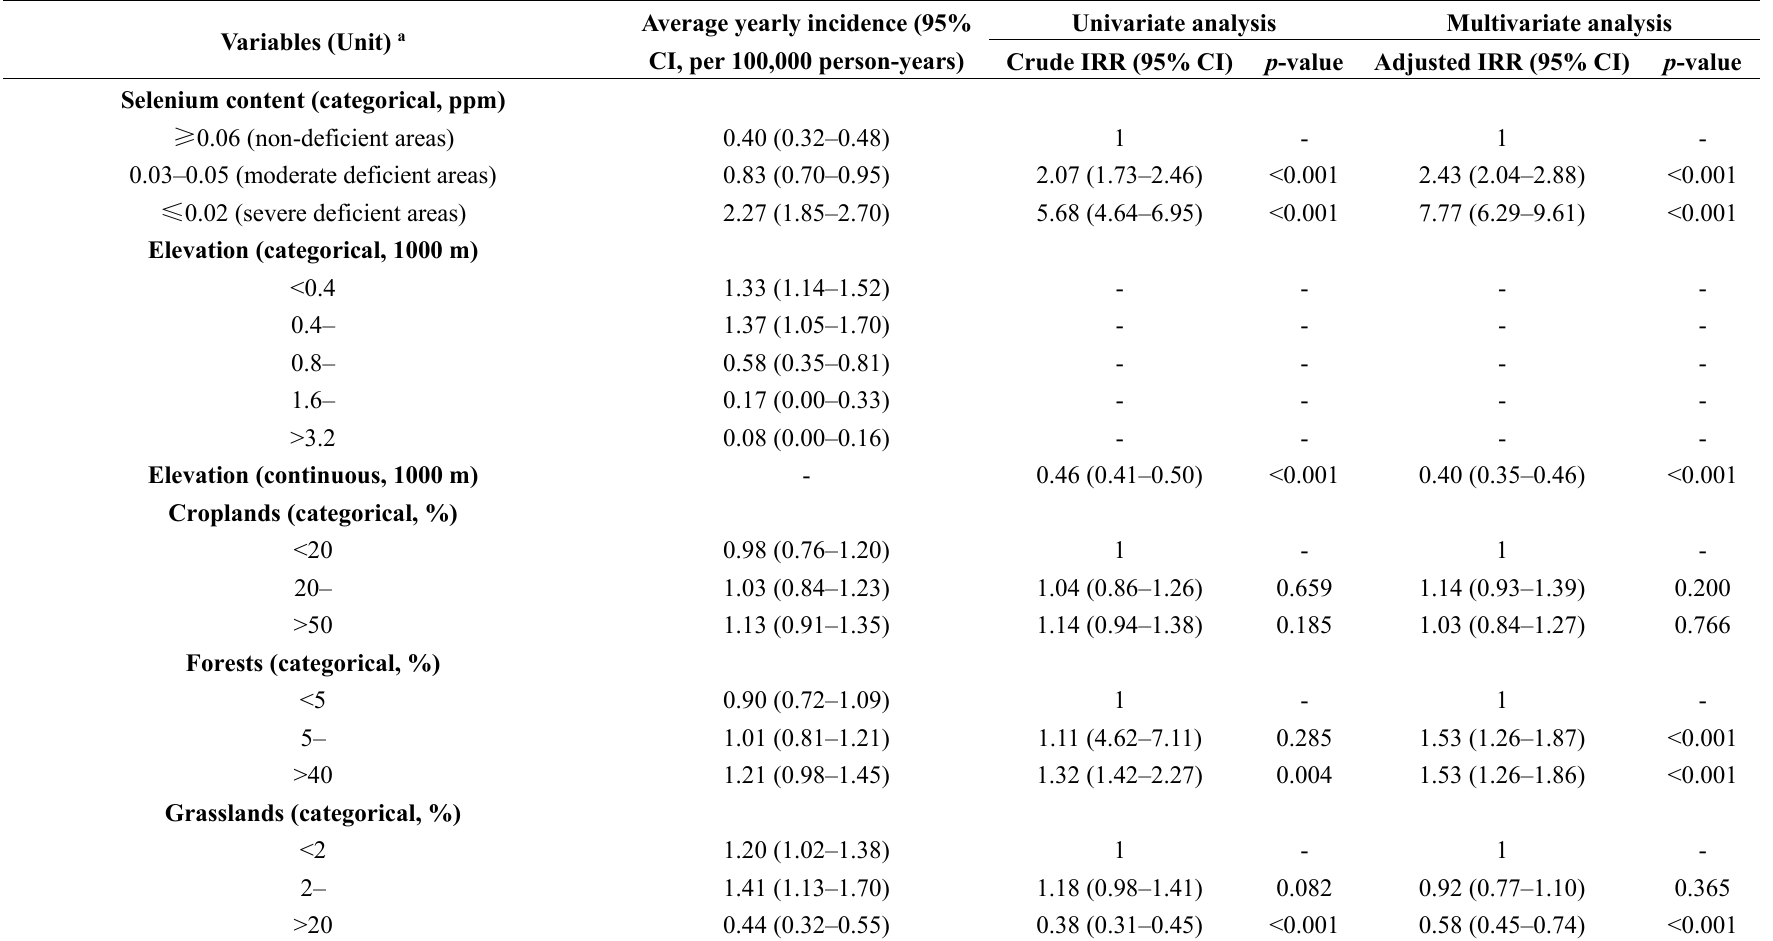
Table 1. The association between hemorrhagic fever with renal syndrome (HFRS) incidence and selenium content of crops and feed by Poisson regression, using data from 2005 to 2010 in Mainland China, both univariately and corrected for other influencing factors in multivariate analysis. IRR is incidence rate ratio. CI is confidence